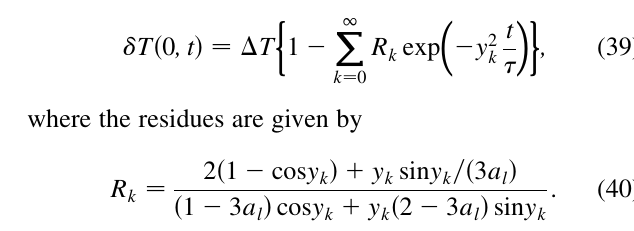
þ F 2 2 . 0 throughout (cid:12)(cid:12)